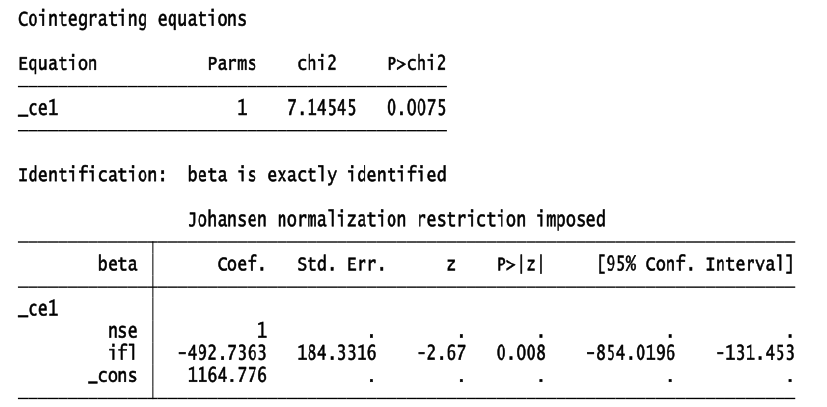
Table 4: Inflation and NSE 20 Share Index Johansen Normalized